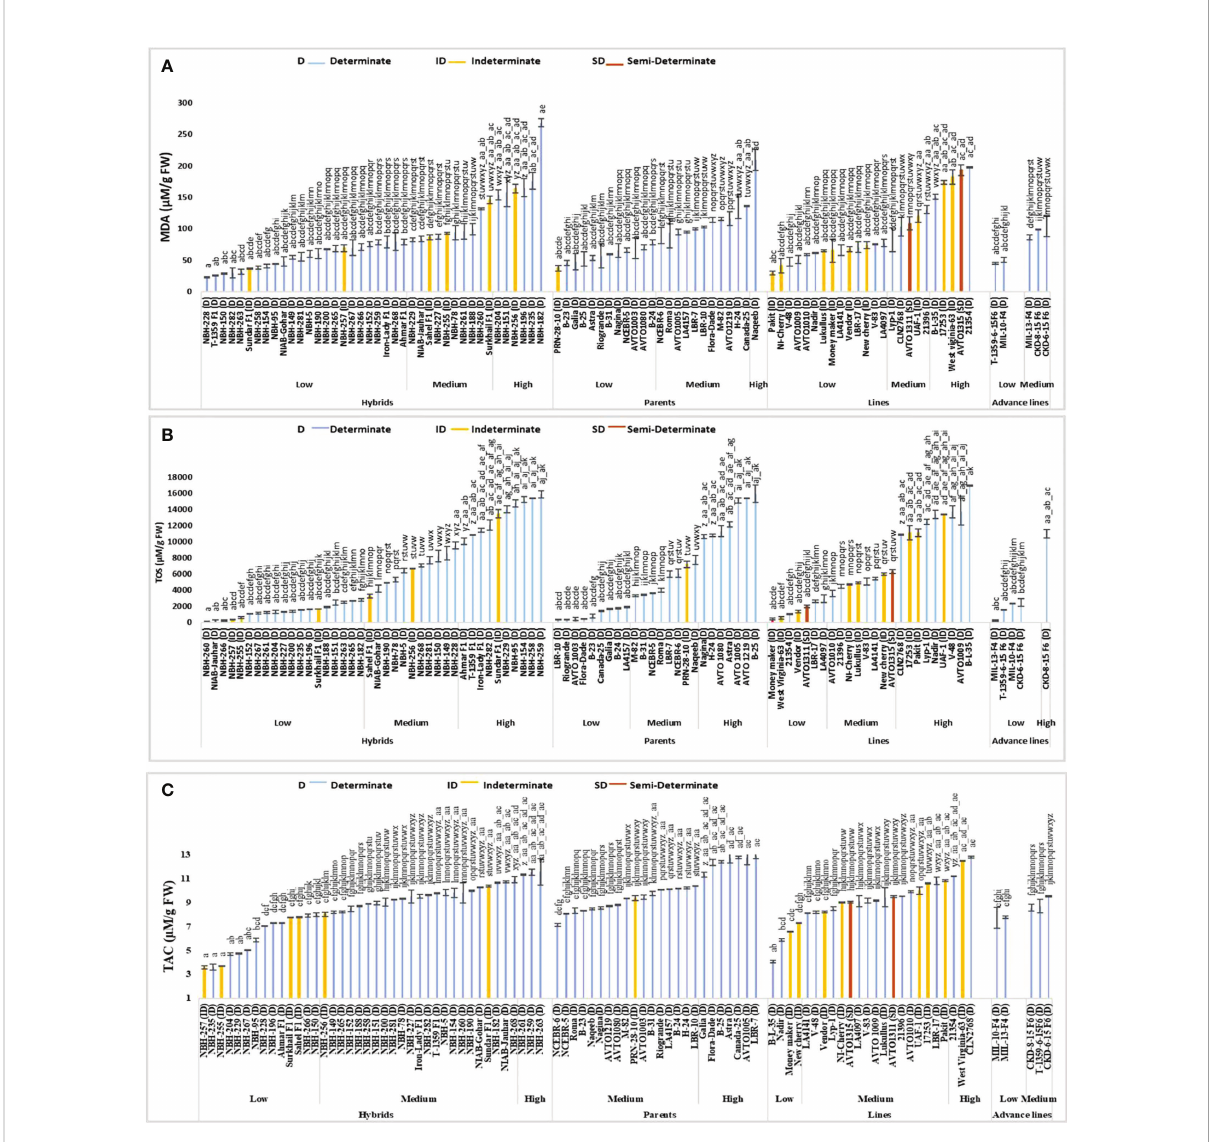
FIGURE 7 Comparison of fruit (A) malondialdehyde (MDA) content, (B) total oxidant status (TOS), and (C) total antioxidant capacity (TAC) in different tomato genotypes (mean value ± SD). Mean value with varying alphabet differs signi fi cantly (p < 0.05, Tukey ’ s